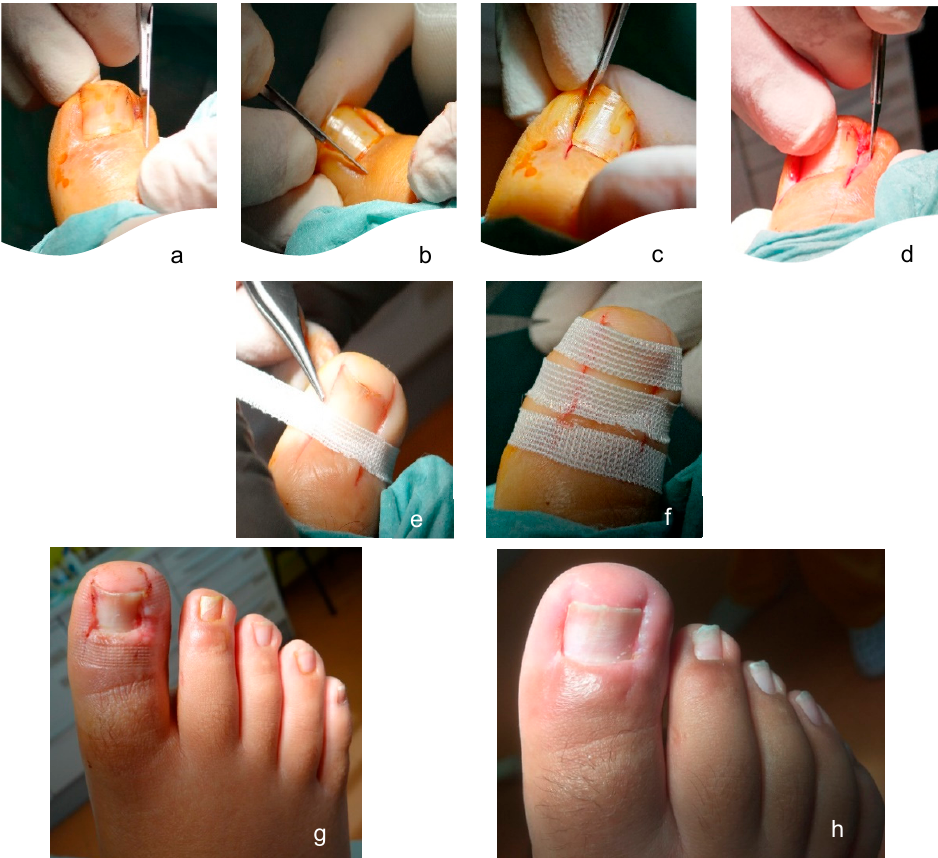
Figure 1. First modification of the Winograd Technique, incision in the eponychium ( a , b ), incision from distal to proximal of the nail plate ( c ), and incision in parabola and oblique movement ( d ). Second modification of the Winograd Technique, using adhesive sutures, with sequential and distal placement, the first strip is superimposed on the eponychium ( e ) and the last on the distal portion of the nail plate ( f ). Seven days postsurgical image ( g ) and 21 days postsurgical image ( h ). All patients were advised to keep their feet elevated (at the level of the pelvic girdle), Patients in both groups were indicated to have 400 mg ibuprofene/8 h for two to walk for five minutes every hour from 12 h after intervention, to wear postoperative footwear, and to not remove or wet the dressing. From the first dressing change, in which the amount of bleeding was assessed, to the last, the evolution was always checked, veri- fying whether there was inflammation, infection, or other variables of interest, as de- one year, and two years.